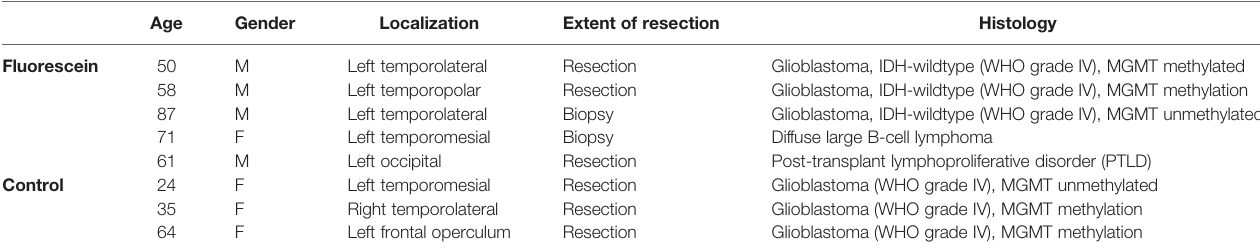
TABLE 1 | Patient